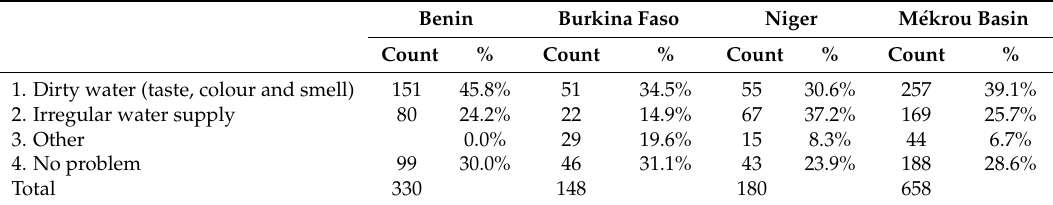
Table 5. Main problem in the domestic water provision.